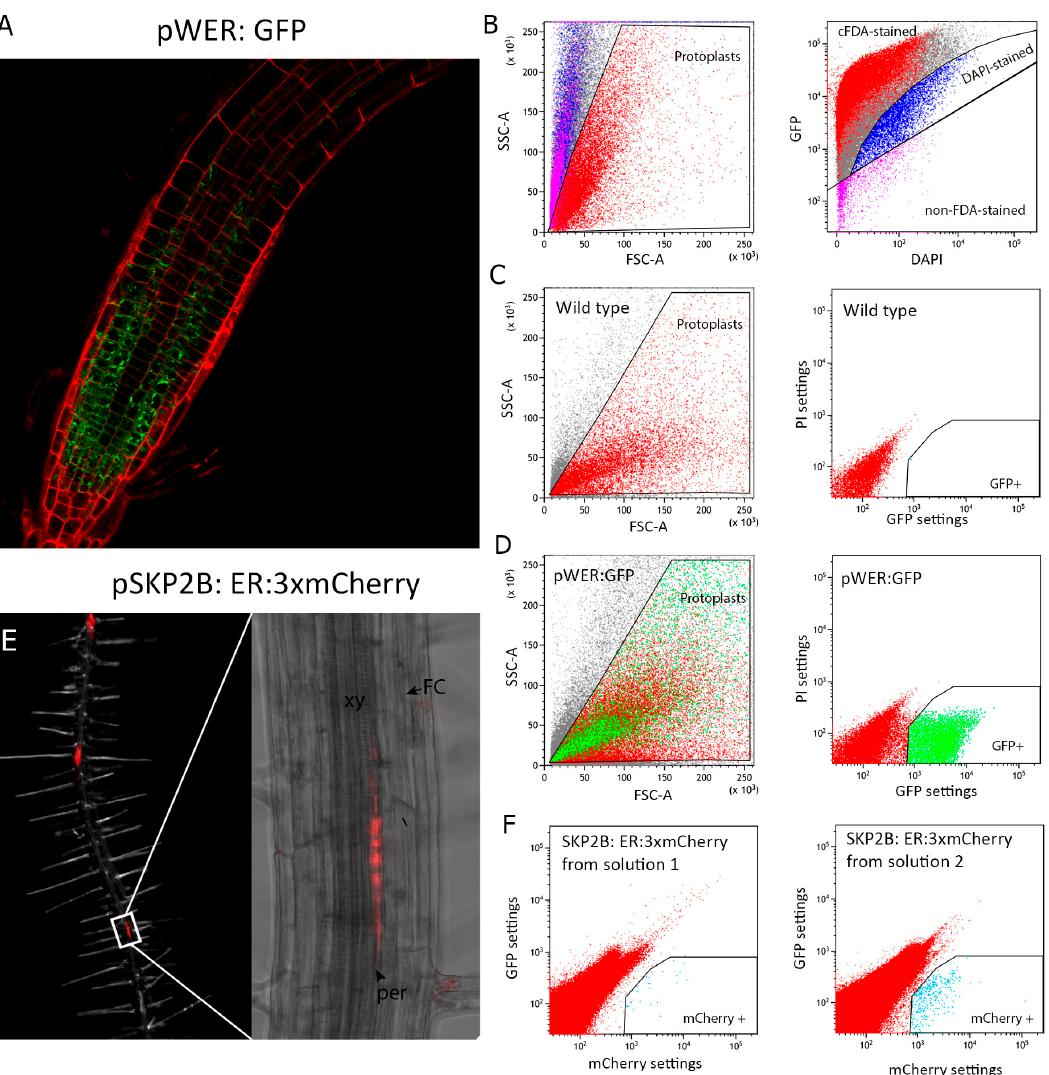
Figure 2. Fluorescence-Activated Cell Sorting (FACS) of root protoplasts. ( A ) Confocal image of plants carrying the fluorescent reporter construct pWER:ER-GFP which marks epidermal cells. ( B ) Left panel: Graphic of forward scatter area (FSC-A, x-axis) versus side scatter area (SSC-A, y-axis) for wild type (nonfluorescent control) protoplast events. Right panel: Plot of GFP fluorescence versus DAPI fluorescence. All samples were stained with cFDA and DAPI and analyzed by FACS. The main subpopulations, corresponding to intact viable protoplasts (red, cFDA-stained, and non-DAPI stained), cells whose membranes were not intact (blue, DAPI-stained), and unviable subpopulations (pink, non-FDA-stained protoplasts) were defined. These subpopulations are shown on the left panel by colors. ( C ) Left: Graphic of forward scatter area (FSC-A, x-axis) versus side scatter area (SSC-A, y-axis) for wild type (non-fluorescent control) protoplast events. Right panel: Plot of propidium iodide (PI) fluorescence versus GFP fluorescence. A gate for GFP-positive (GFP + ) protoplast collection was defined. ( D ) Left panel: FSC-A / SSC-A plot of pWER:ER-GFP line protoplast events. Right: PI signal versus GFP fluorescence plot of pWER:ER-GFP protoplast. ( E ) pSKP2b 0.5Kb :ER-3xmCherry line expression in lateral root founder cells; FC: Founder cell, per: pericycle, xy: xylem. ( F ) Green versus mCherry signal plot of pSKP2B 0.5 :ER-3xmCherry viable protoplasts during FACS, using solution 1 (Left panel) or solution 2 (Right panel). Light blue dots: mCherry-positive protoplasts.